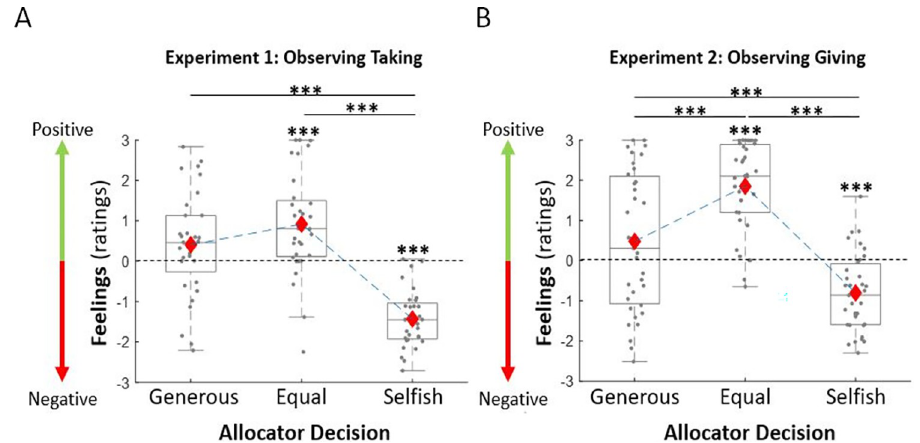
Fig 2. Feelings are negative when observing selfish behavior, positive when observing equal splits, and neutral when observing generosity. Observers report negative feelings when observing allocators act selfishly and positive feeling when observing equal splits. Surprisingly, feelings were not positive (nor negative) when observing generosity. This is true both in Experiment 1 (A, left panel) and Experiment 2 (B, right panel). The grey dots represent the mean feelings rating per allocator type for each participant. Red diamonds represent the average of these means. The box plots show the distribution of the participants’ mean feelings about each allocator: boxes indicate 25–75% interquartile range, whiskers extend from the first and third quartiles to most extreme data point within 1.5 × interquartile range, and the median is shown as a horizontal line within this box. ��� p < 0.001.